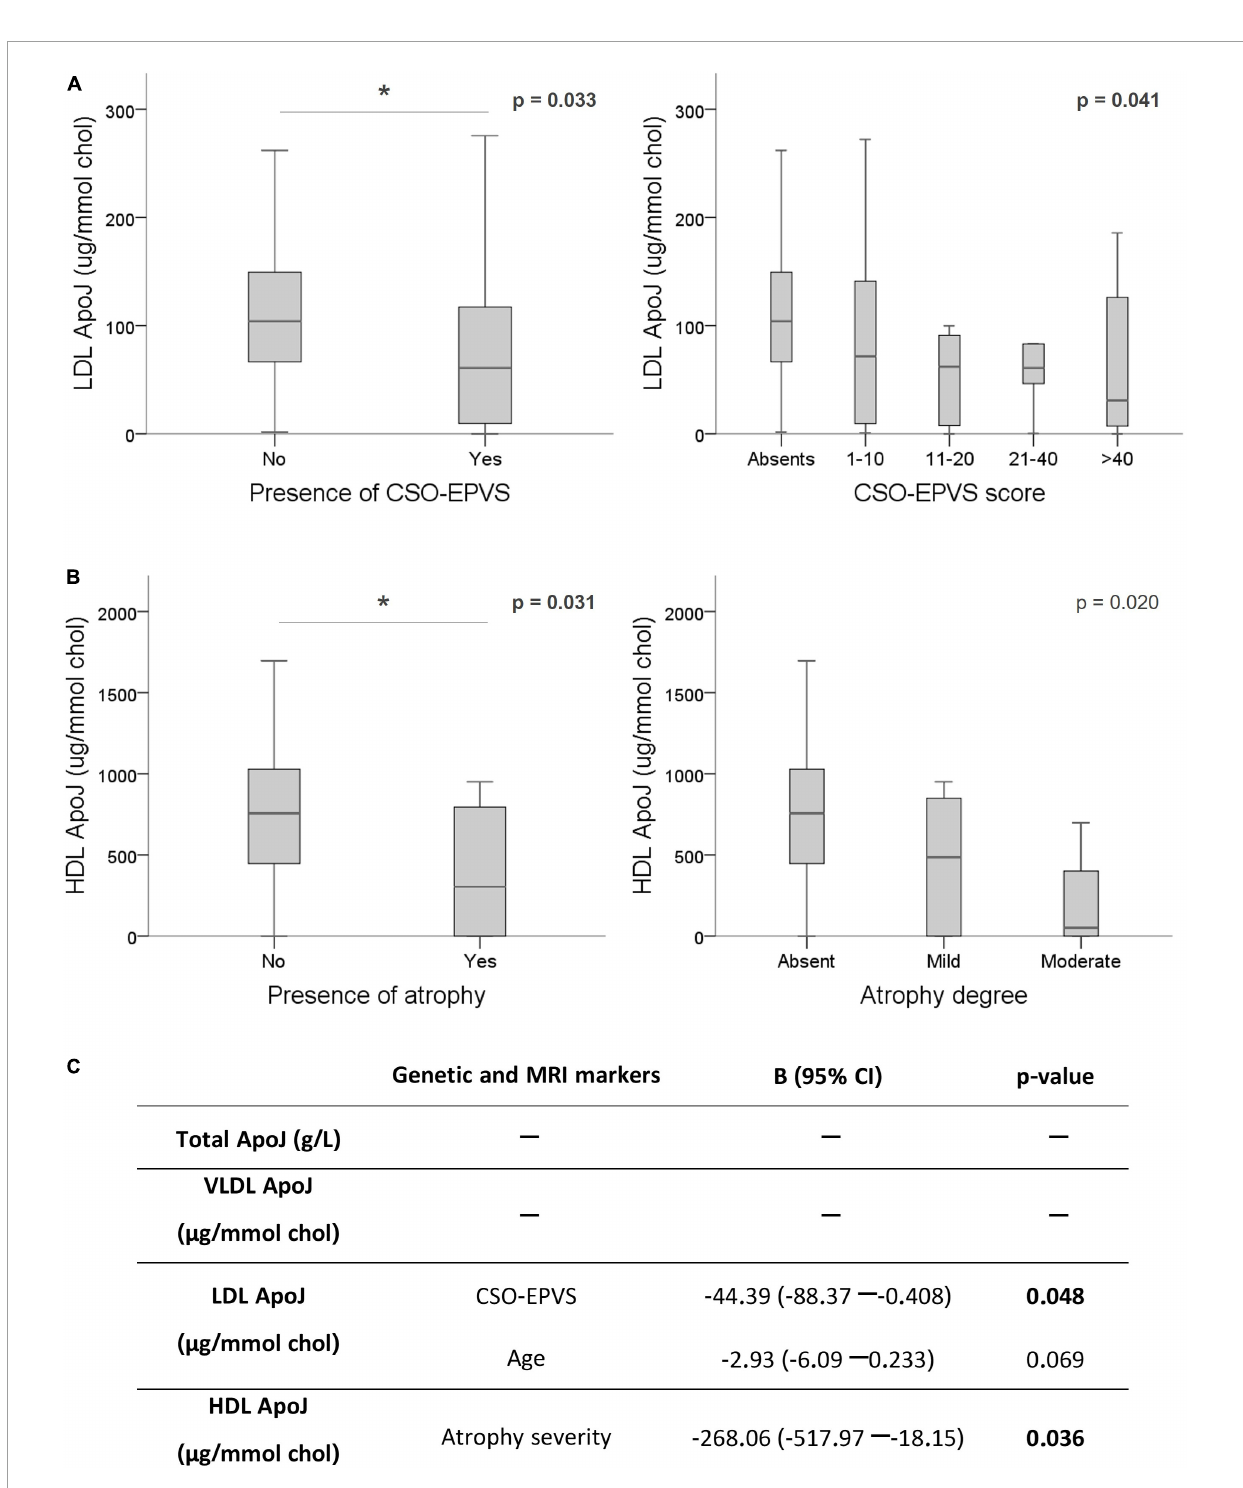
FIGURE3 Association of ApoJ levels with MRI features associated with CAA. ApoJ levels are expressed as µ g of ApoJ per mmol of cholesterol in each lipoprotein. (A) Boxplot representation of ApoJ levels in LDL according to EPVS in centrum semiovale (CSO). (B) ApoJ levels in HDL according to the presence and severity of cortico-subcortical atrophy. (C) Linear regression for circulating ApoJ levels using the significant variables for each lipoprotein fraction (CLU SNPs and MRI markers) and adjusting by sex and age. * p < 0.05.